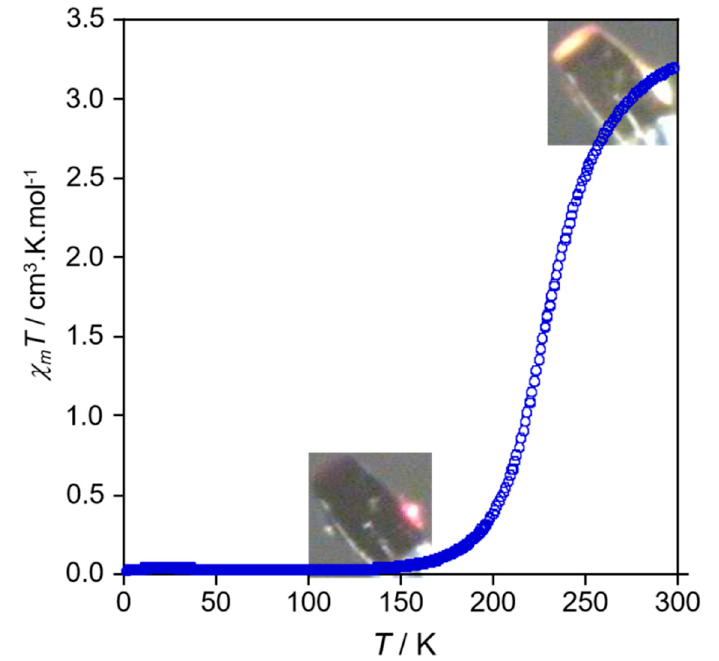
Figure 3. Thermal variation of the χ mT product for complex [Fe(dpea) 2 (NCS) 2 ] ( 1 ).